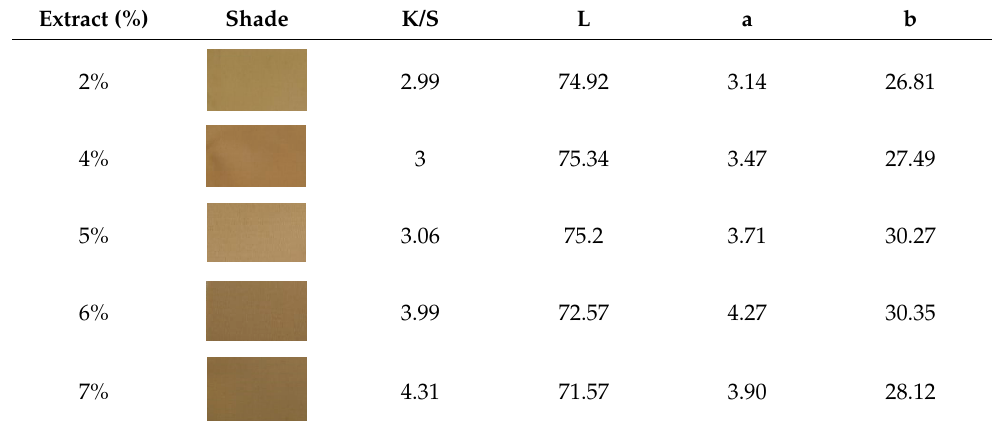
Table 2. Shades and colorimetric data obtained for the dyed polyamide fabrics at different concentrations. Extract (%)